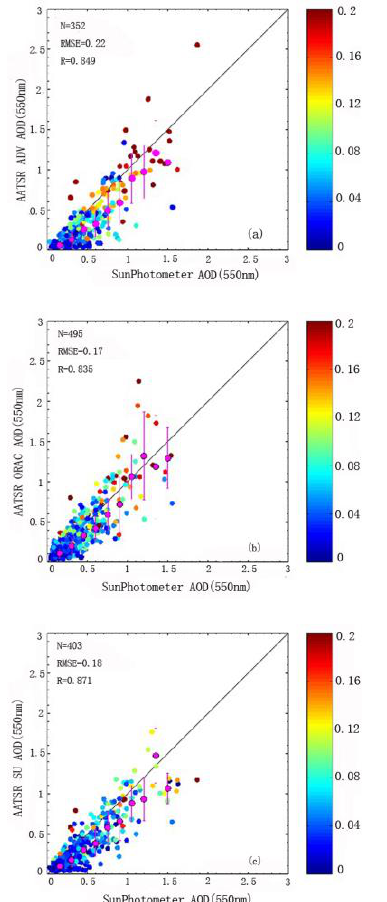
Figure 4. Scatter panels of three AATSR AOD with Sun Photometer AOD (AERONET and CARSNET)